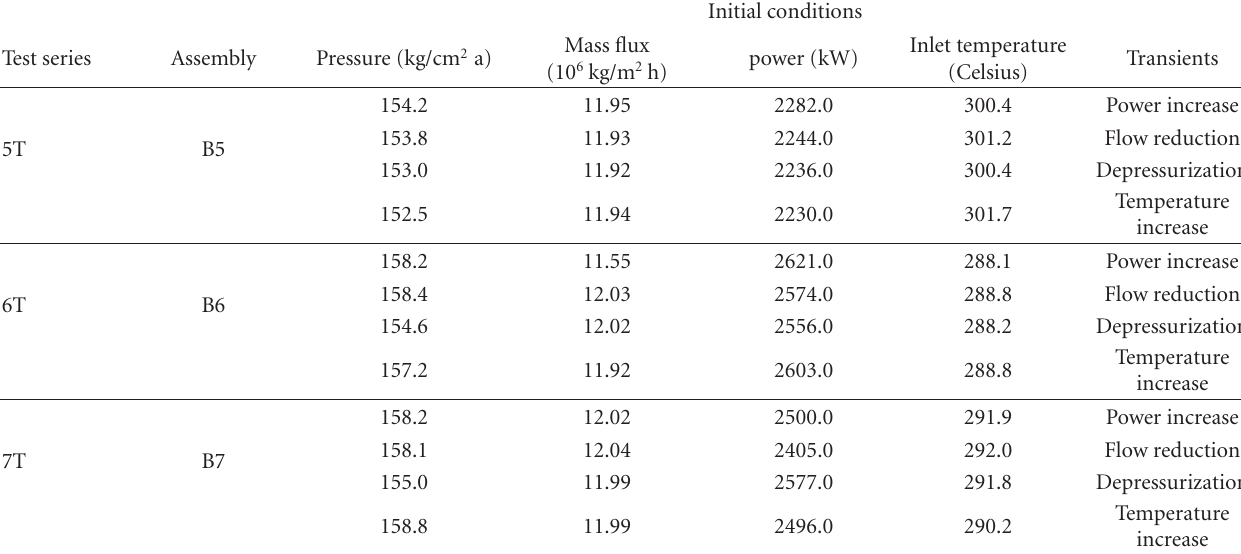
Table 7: Initial conditions for transient bundle tests